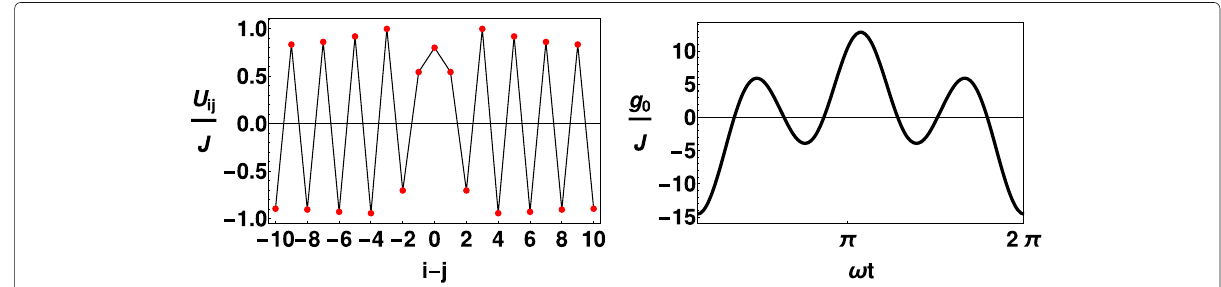
Fig. 7 Left panel: effective long-range interaction coefficients as a function of the distance i − j between temporal lattice sites in the Bose-Hubbard Hamiltonian (7) in units of the tunneling amplitude J . The character of the interactions changes between repulsive ( U ij > 0) and attractive ( U ij < 0) in an oscillatory way vs. i − j . Right panel: periodic changes of the original contact interaction strength g 0 ( t ) between ultracold atoms that results in the effective interactions presented in the left panel, cf. Eq. (8). Reprinted from